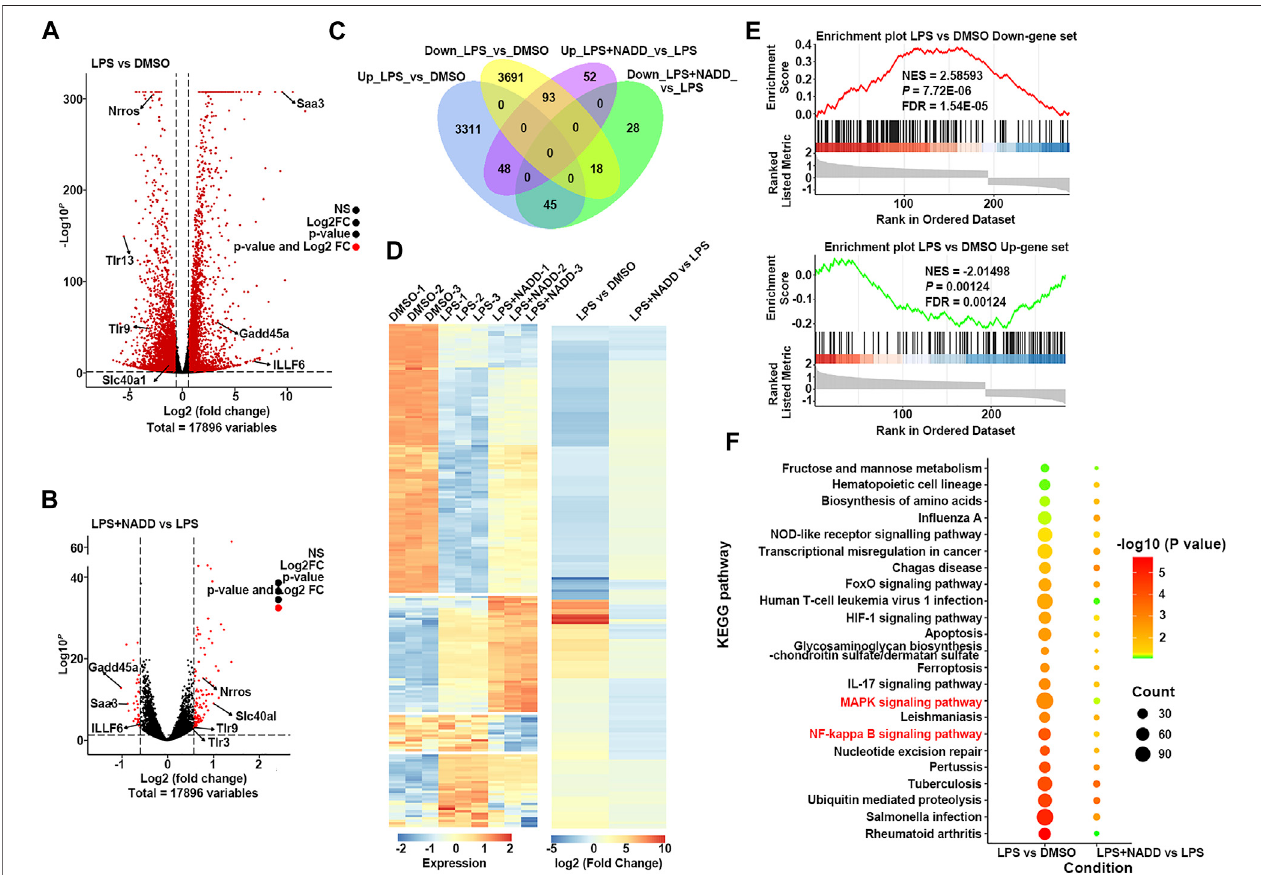
FIGURE 5 | The result of RNA-seq. (A) The volcano plot of DEGs between LPS and DMSO treated RAW264.7 macrophages; The red dots show signi fi cantly DEGs. (B) Volcano plot of DEGs between LPS + NADD LPS treated RAW264.7 macrophages; the red dots show signi fi cantly DEGs (C) Venn diagrams of overlapping genes with LPS only treatment and LPS + NADD treated RAW264.7 macrophages. (D) Heatmap of 204 common DEGs in LPS and LPS + NADD treated RAW264.7 macrophages. (E) GSEA analysis result of DEGs. (F) KEGG enrichment analysis of DEGs. The DEGs were de fi ned by |foldchange| > 2 and p < 0.05.